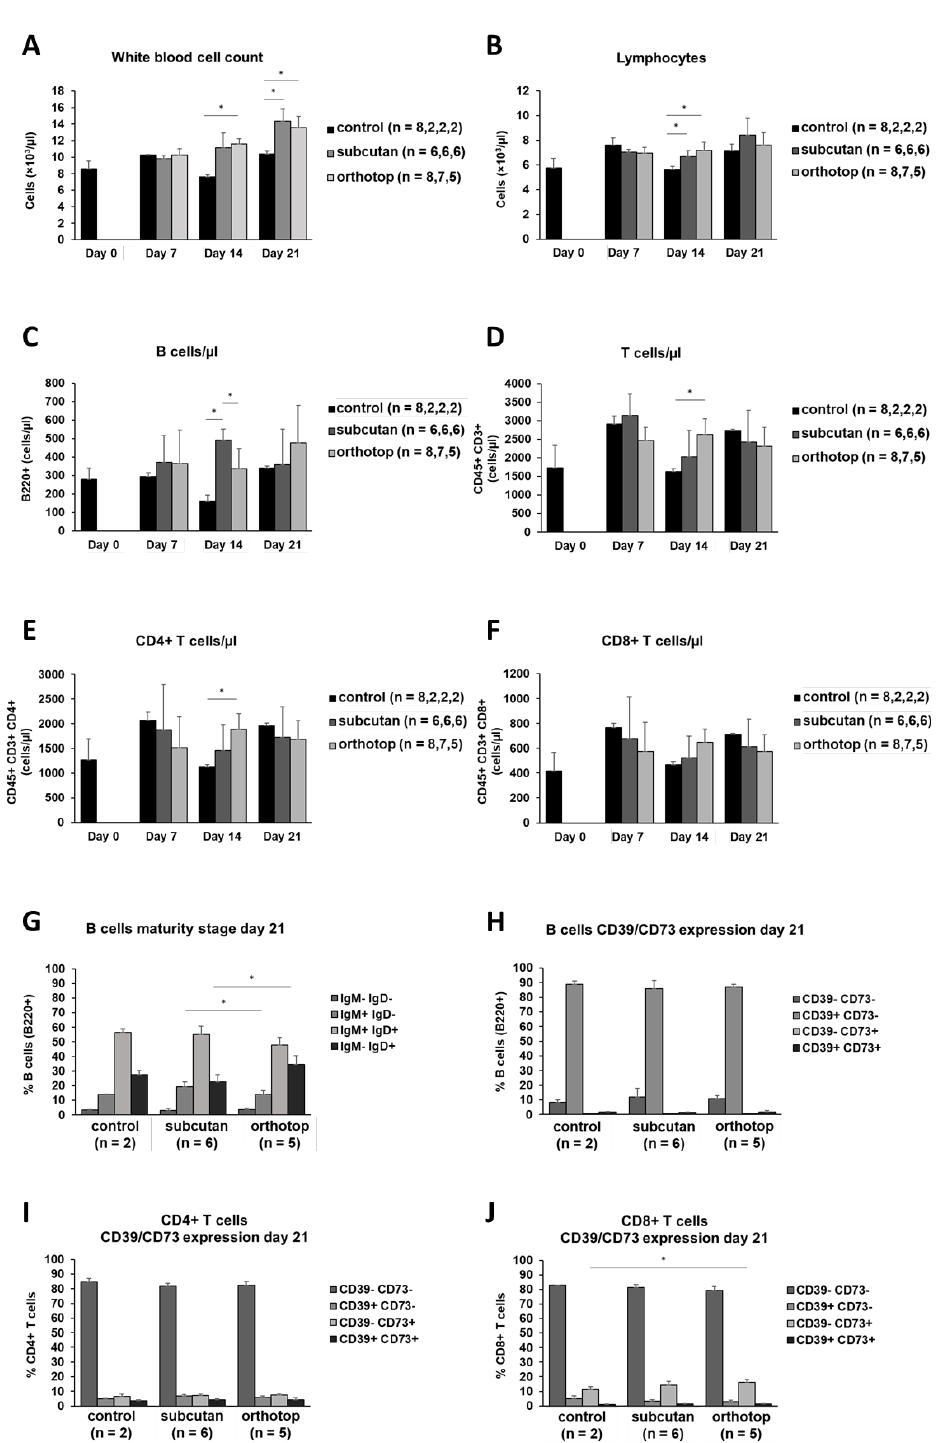
Figure 5. Cell populations in the peripheral blood of orthotopic and subcutaneous HNSCC-bearing mice. Leukocytes ( A ) and lymphocytes ( B ) were determined using an animal blood counter. ( C – F ) Populations of B cells and T cells were analyzed using flow cytometry. ( G , H ) The expression profile for IgM/IgD and CD39/CD73 was determined on peripheral B cells. ( I , J ) The expression profile for CD39/CD73 was determined on T cells. Cell numbers per µl blood were calculated based on the white blood cell count (WBC). Values are shown for day 0 (control), day 7, day 14, and day 21. On day 7, day 14, and day 21, the test group size for the subcutaneous group is n = 6, while for the control group n = 2. On day 0, the test group size for the control group is n = 8. The test group size for the orthotopic group on day 7 is n = 8, day 14 n = 7, and day 21 n = 5. p -values < 0.05 were considered to be significant with (*). Data shown here are listed in Table S2.